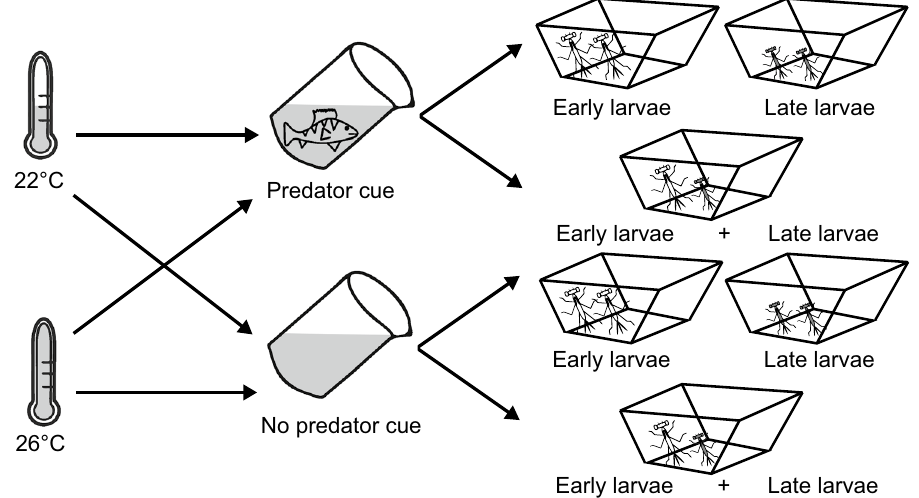
Figure 1. A schematic graph visualizing the full factorial experimental design with two temperature treatment groups crossed with two different predator cue treatment groups, that were each divided into four different phenology groups, resulting in 16 treatment combination groups. Note that in reality 16 larvae were present per